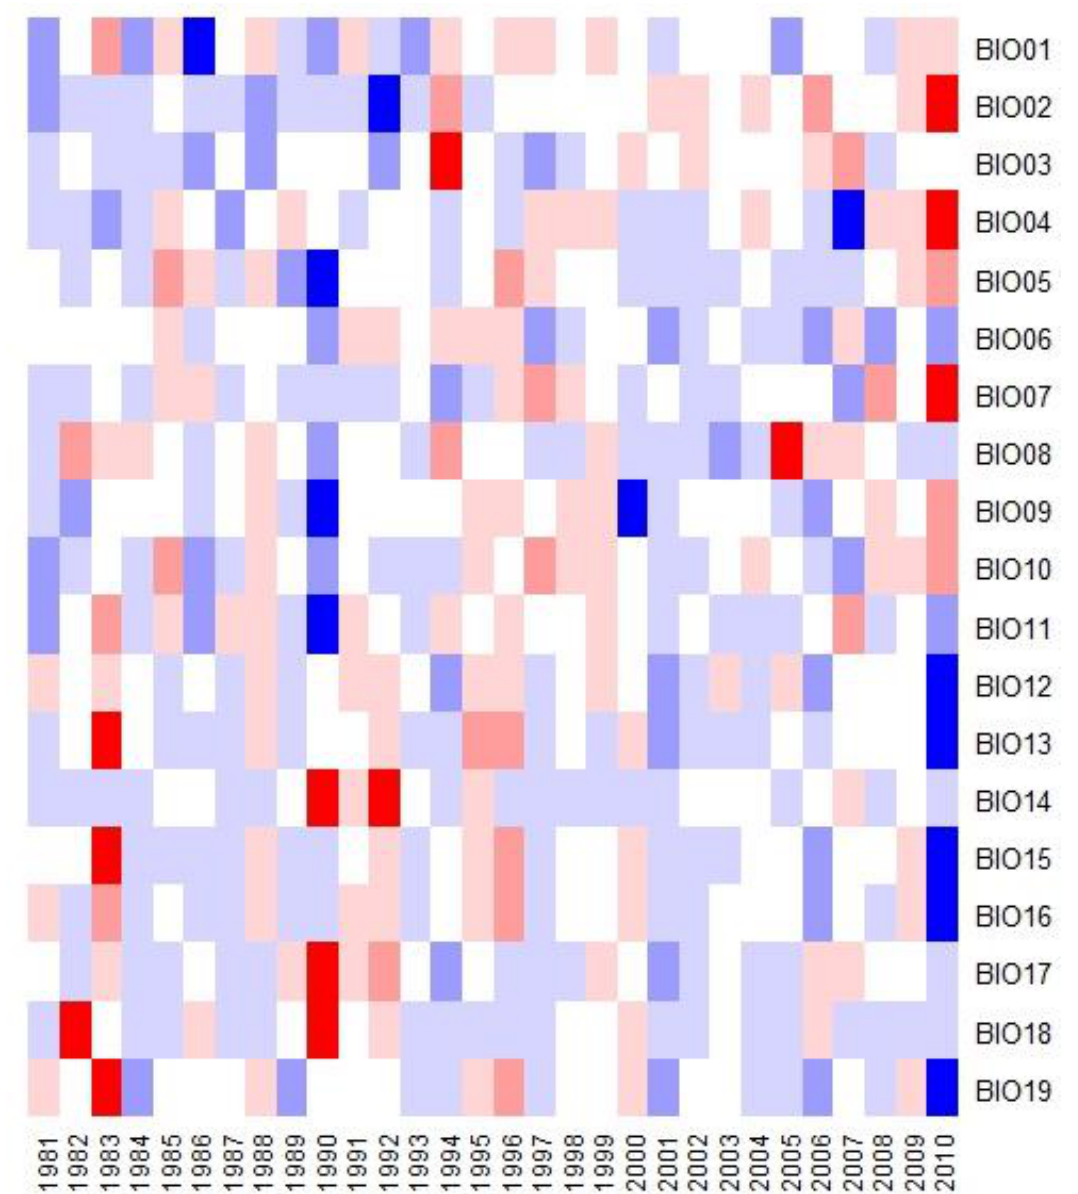
Figure 8. Relatively scaled (by index) hepta-class heatmap of NJF spatially aggregated bioclimatic variables [53] for the period 1981–2010. Derived from the AWAP [39] using Hijmans et al . [54]. Red colours represent quantities greater than the mean (white) and blue less than, intensity represents